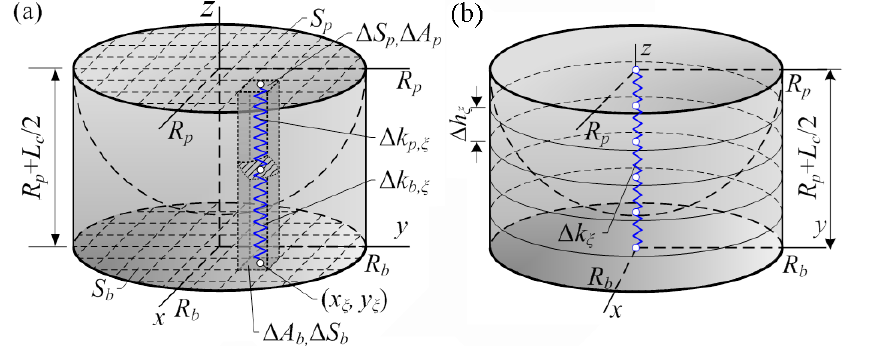
Figure 2. Concepts of the discretisation of a half of the conditional connecting elements: by parallel connected prisms ( a ) and by sequentially connected rings ( b